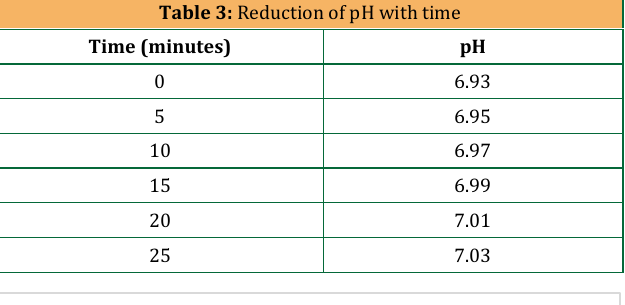
Table 3: Reduction of pH with time